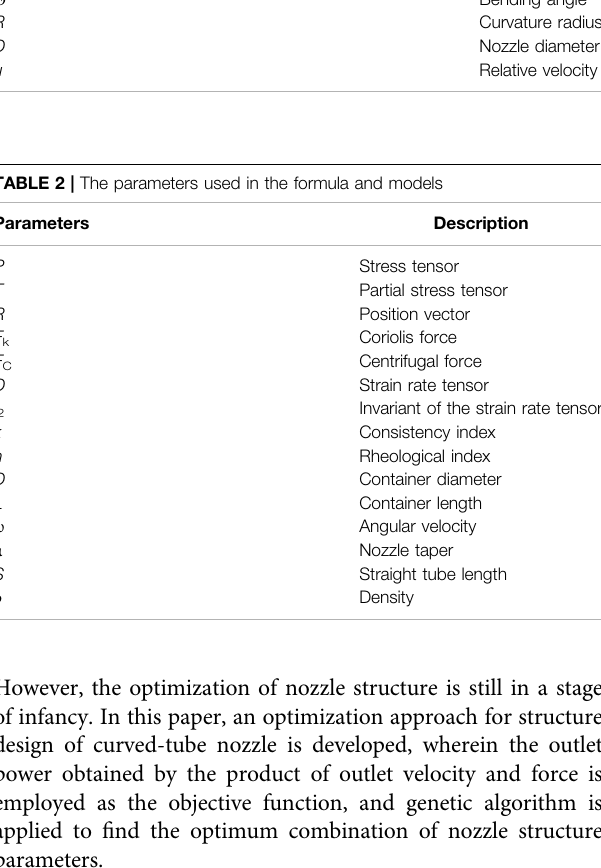
FIGURE 2 | The structure of curved-tube nozzle.